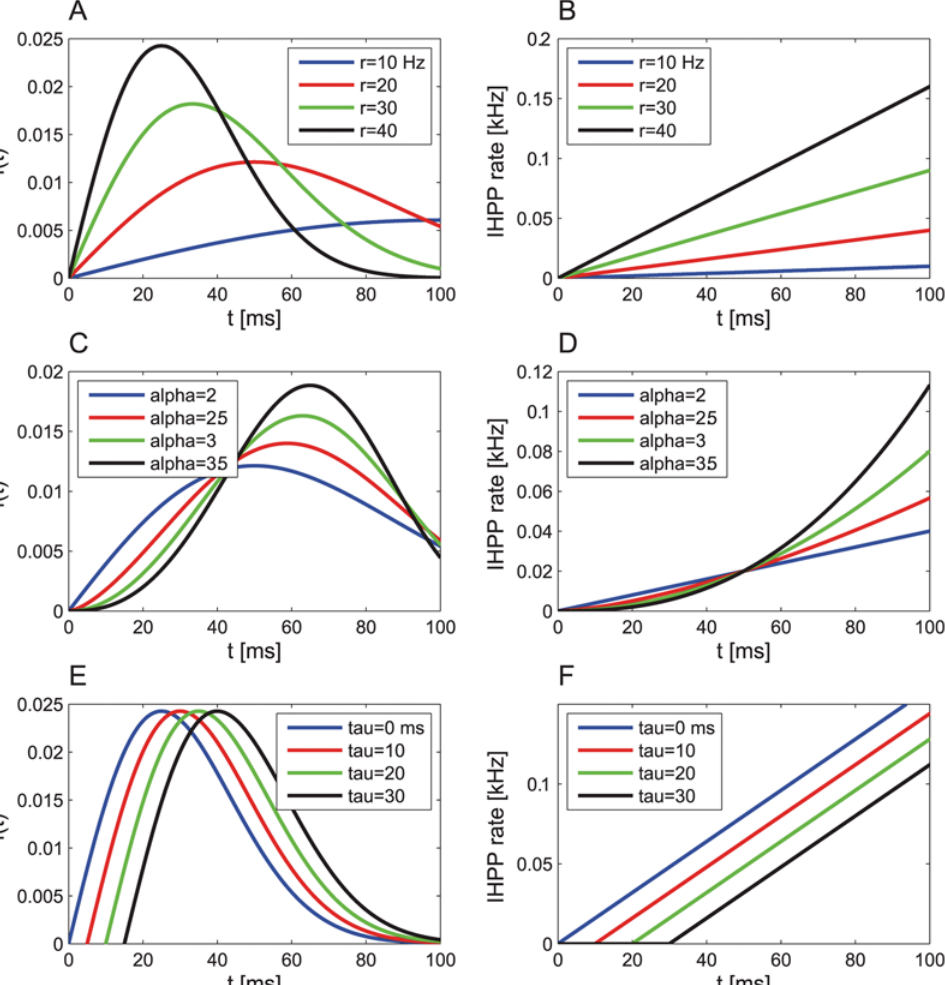
Figure 1. Three examples showing the effects of the scale parameter (a,b), the shape parameter (c,d), and the delay parameter (e,f) on the first spike time probability density, f t ð Þ , (left column) and the PSTH rate, r t ð Þ , of a corresponding inhomogeneous Poisson process (right column). The PSTHs were taken to be of the form of r t ð Þ ~ r a t { t ½ (cid:1) a { 1 z (compare with equation 5), and f t ð Þ is obtained via the relation of equation (6). The parameters used to generate the plots are as follows. For a and b: t ~ 0 ms , a ~ 2 , and r as appears on the figure. For (c,d): t ~ 0 ms , r ~ 20 Hz , and a as appears on the figure. For (e,f): a ~ , r ~ 40 Hz , and t as appears on the figure.